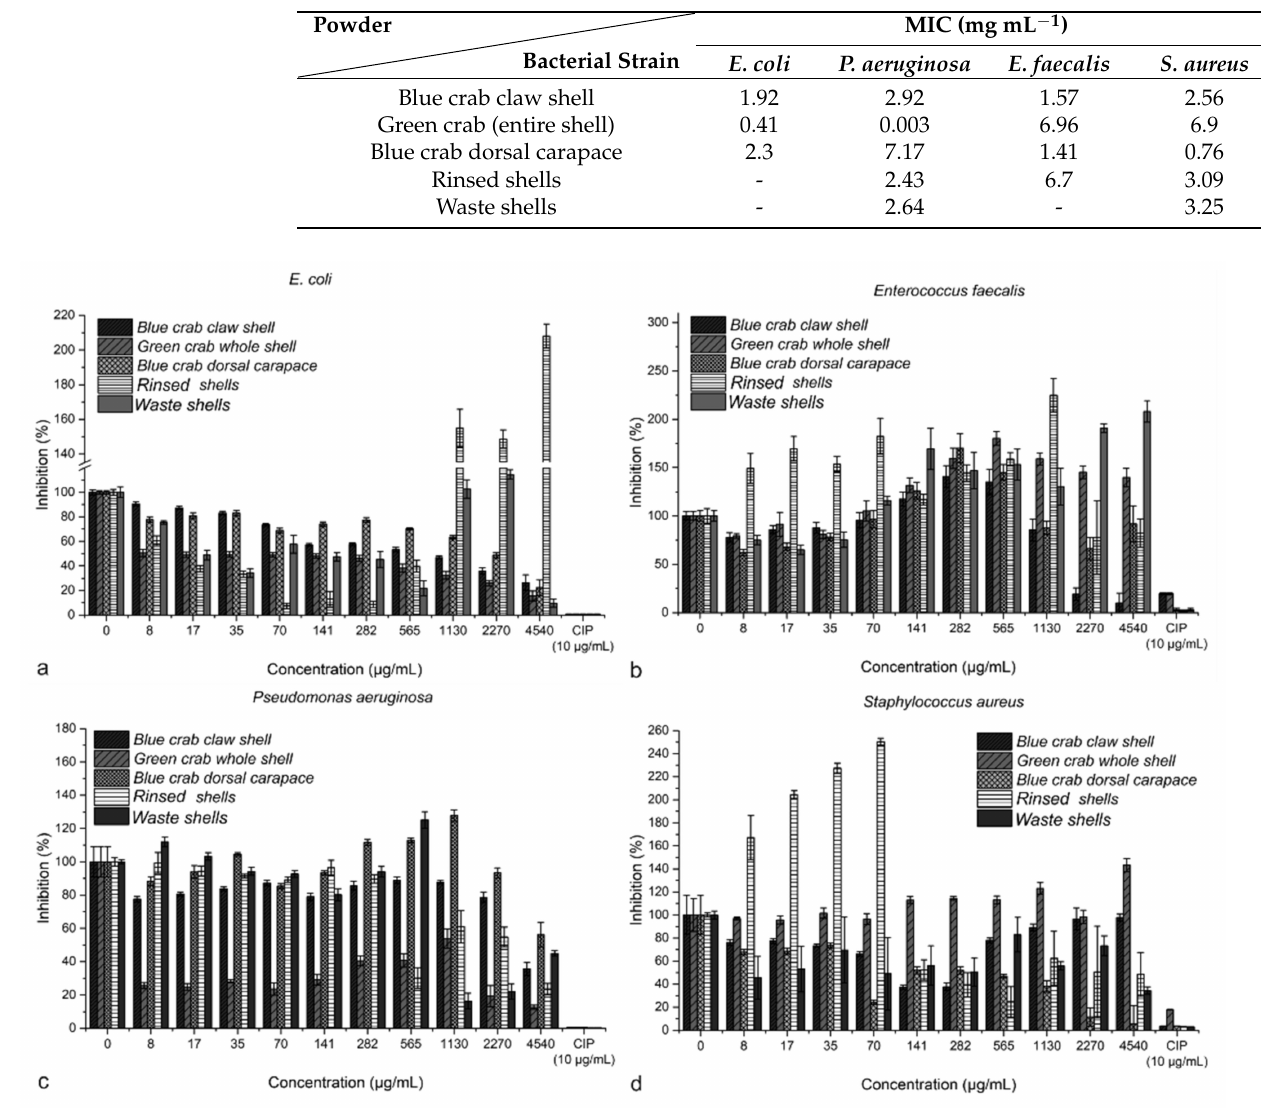
Figure 4. The antibacterial effects of crab shell powders against Escherichia coli ( a ), Enterococcus faecalis ( b ), Pseudomonas aeruginosa ( c ), and Staphylococcus aureus ( d ), assessed through the microdilution method. CIP =